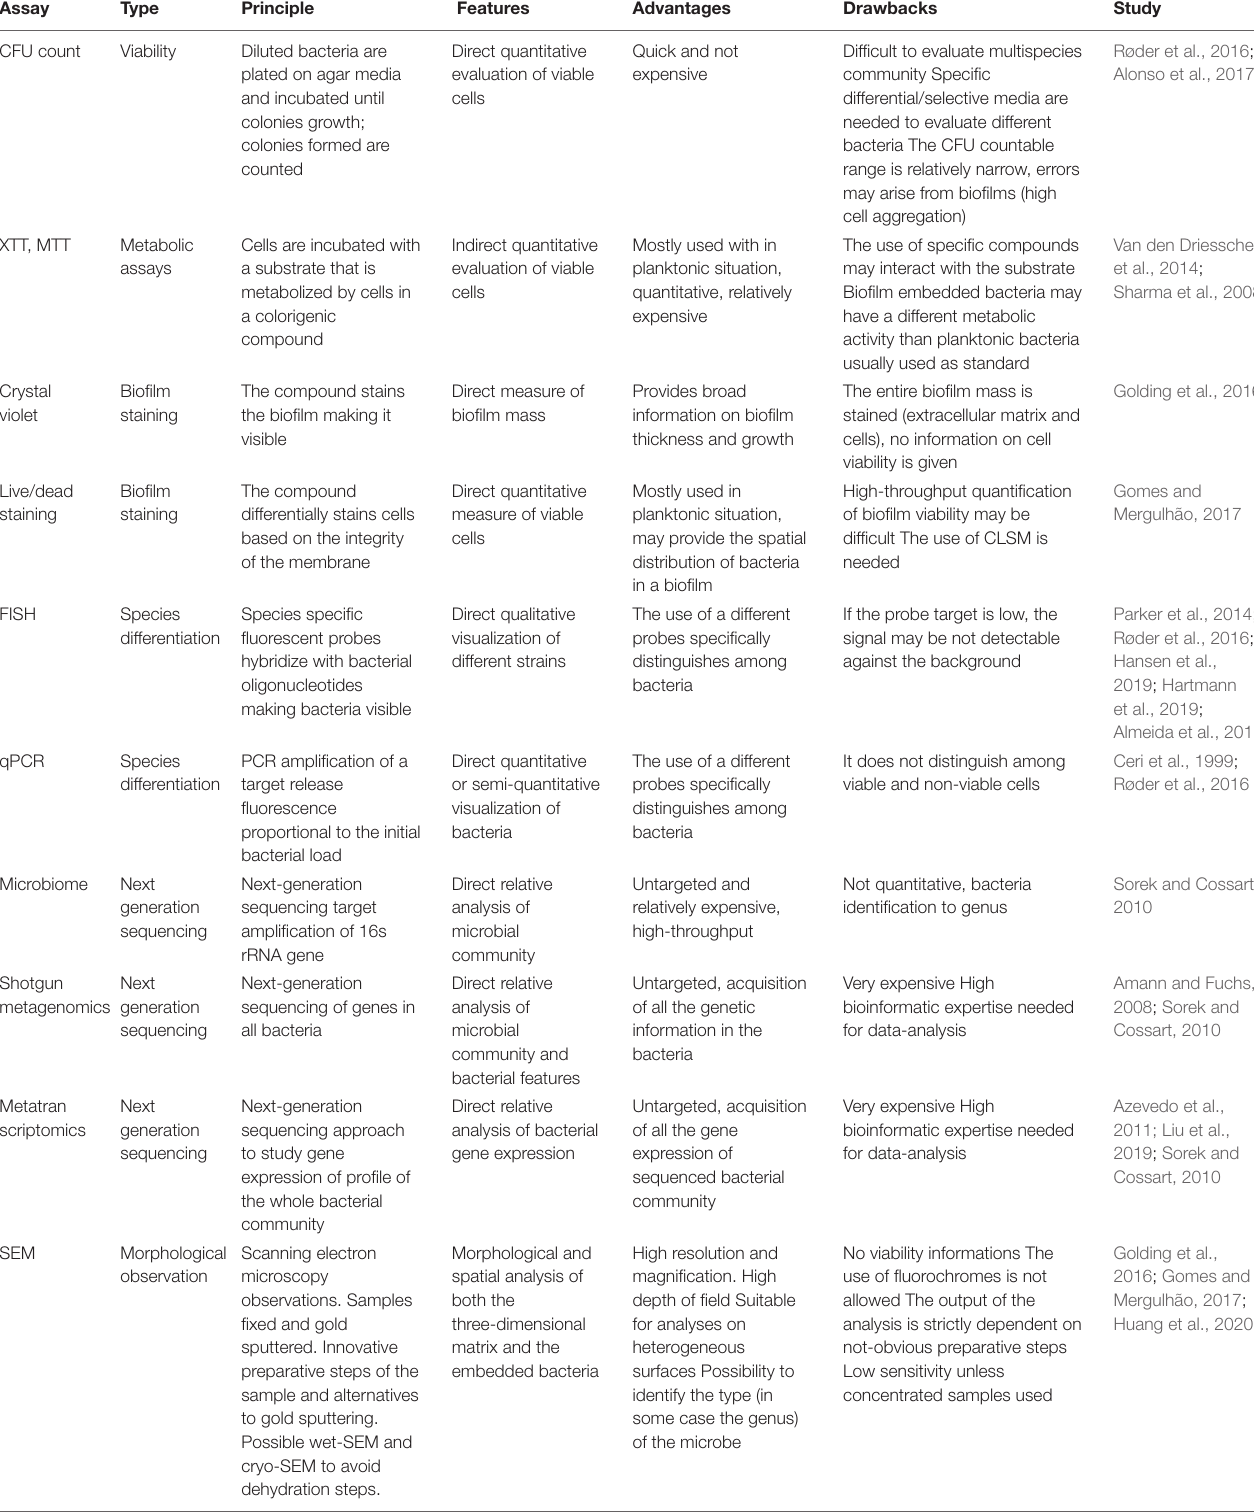
TABLE 3 | Schematic overview of the strategies available to study biofilm embedded bacteria.